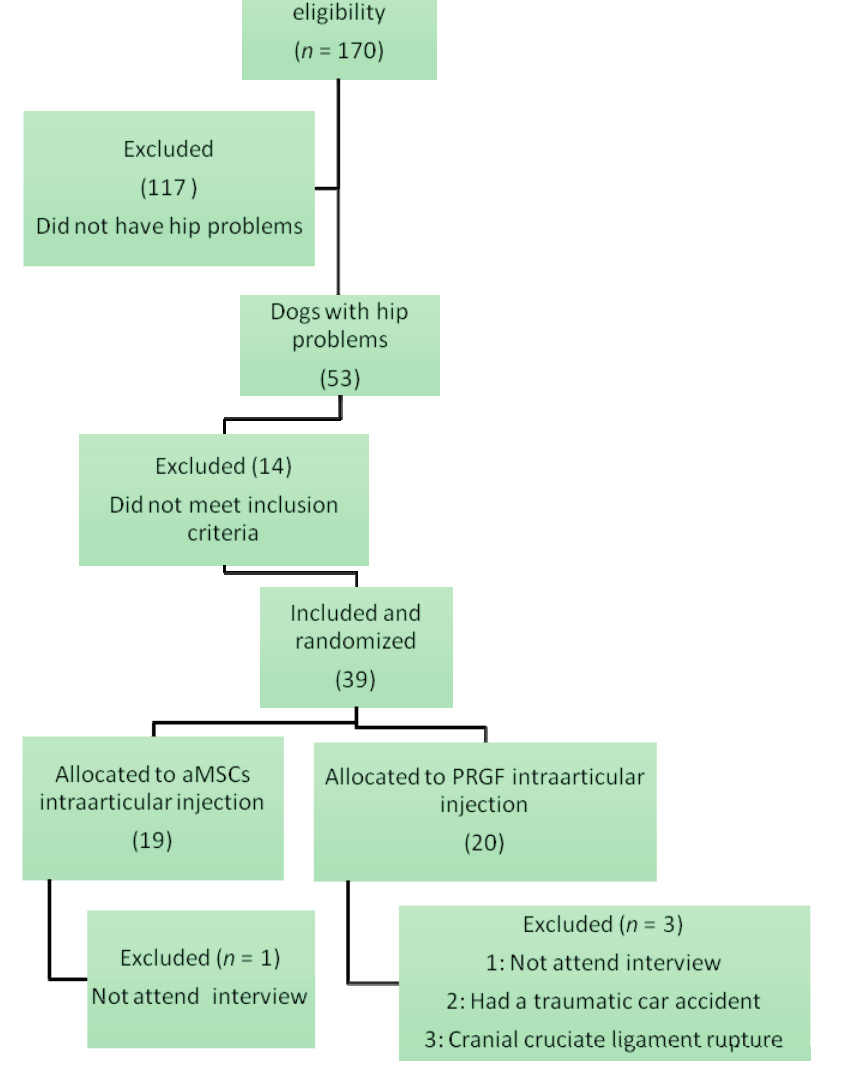
Figure 1. Enrollment and outcomes.